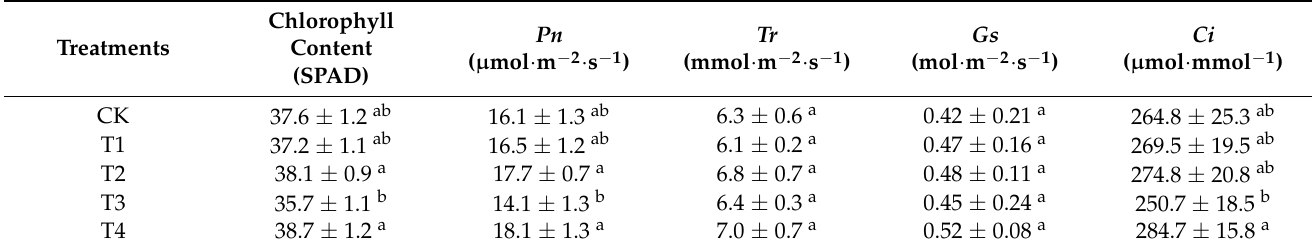
Table 2. Chlorophyll content and photosynthetic performance of tomato leaves supplied with different dynamic concentrations of nutrient solution. Pn , the net photosynthetic rates; Tr , transpiration rate; Gs , stomatal conductance; Ci , intercellular CO 2 concentration.